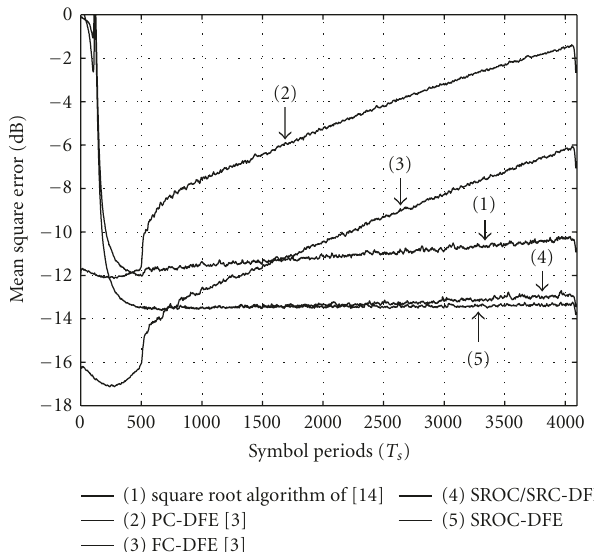
Figure 6: Uncoded BER of equalizers for a 4 × 4 system trained for 512 T s , and operating over a time-varying frequency-selective MIMO channel at SNR = 16dB. The normalized Doppler fre- quency ranges from 1 · 10 − 6 to 1 · 10 − 4